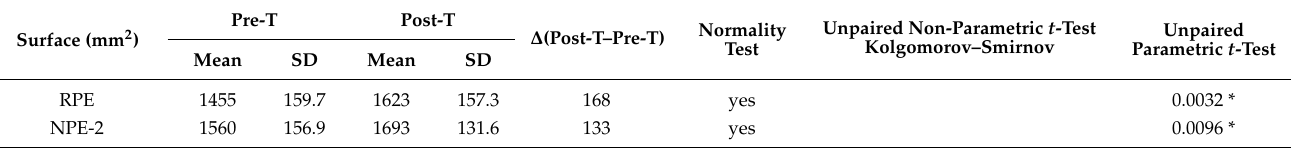
Table 5. Mean values of palatal surface before and after treatment in patients treated with RPE and NPE-2.